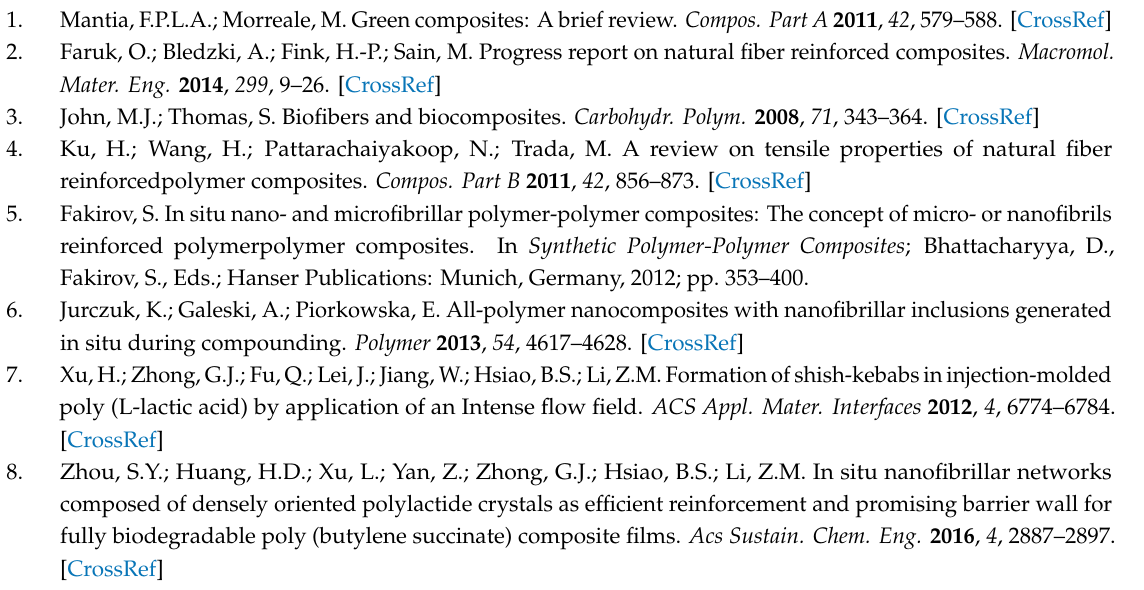
Figure S1: Shear rate dependences of the complex viscosity for the matrix, PLA (a) viscosity ratio of blend to matrix (b) measured at 135, 155, 180 ◦ C; Figure S2: Melting endotherm of PLA / PHA composite; Figure S3: Loss modulus of PLA, PHA and PLA / PHA composite in a tensile mode; Figure S4: True stress–Hencky strain curves of PHA nanofibers network for PLA / PHA nanocomposite determined at 100 ◦ C and Hencky strain rates of 0.1, 0.2, and 0.4 sec-1. Plots obtained by subtracting stress-elongation curve for neat PLA from respective stress-elongation curves for the nanocomposite; Table S1: Mechanical properties of PLA, PLA / PHA blend and